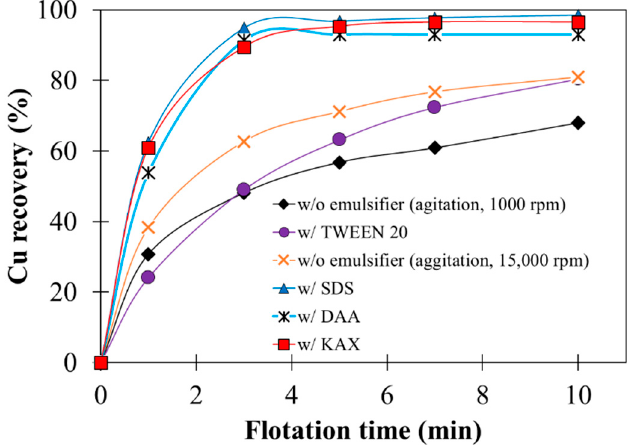
Figure 7. Cu recovery with time (agglomeration conditions: 30 min; 1000 rpm with emulsifiers, 1000 and 15,000 rpm without emulsifiers).